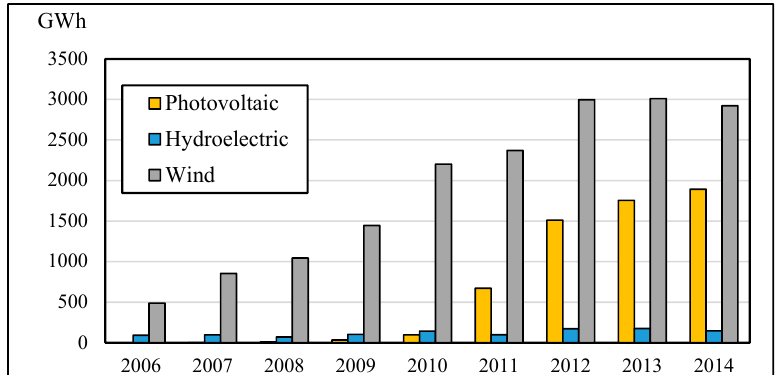
Figure 4. Electrical energy production by renewable sources in Sicily in decade 2004–2014.